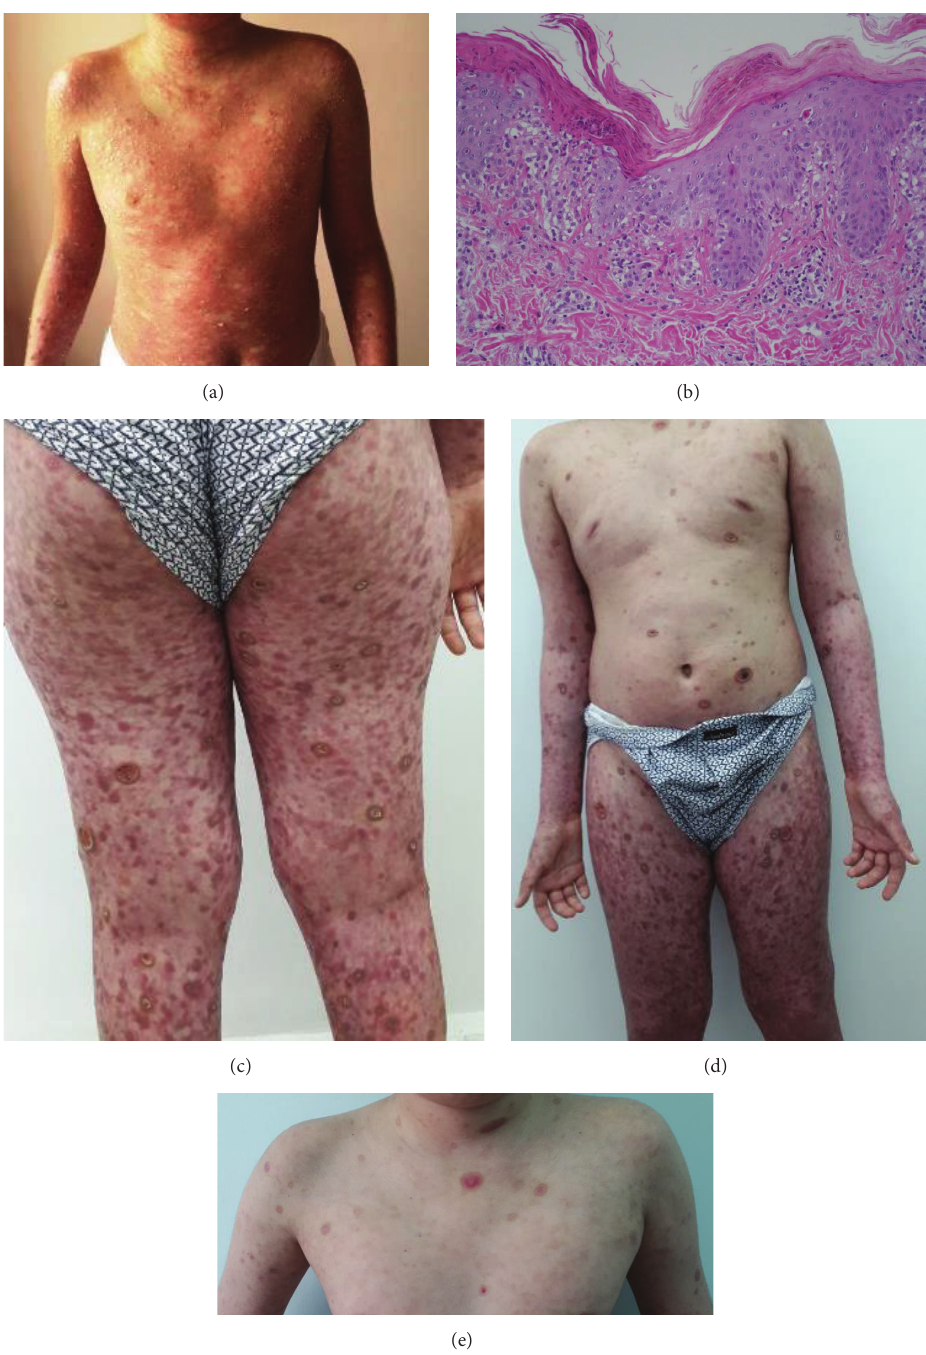
Figure 1: (a) Erythematous macules, papules, and pustules on the trunk. (b) Histopathology of the skin lesion showing parakeratosis, extension of infiltrate into epidermis, vacuolization of basal layer with necrotic keratinocytes, and mixed inflammatory cell infiltration around the vessels and in the upper dermis (HE × 200). (c) Necrotic ulcers, erythematous papules, and plaques on the limbs. (d) Clinical appearance after six doses of methotrexate. (e) Clinical appearance five months after the patient’s initial